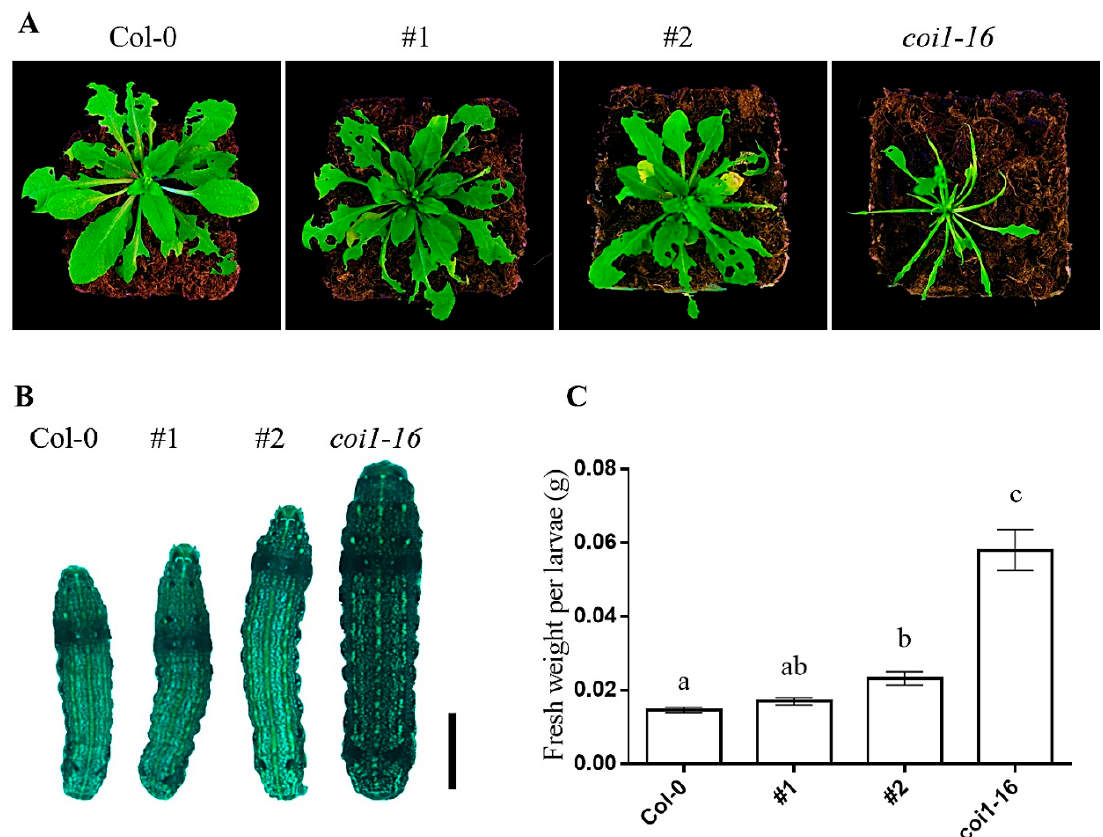
Figure 7. The defense response to herbivory in Col-0, #1, #2, and coi1-16 mutant. The overall appearance of Arabidopsis plants after 10 days of feeding by larvae ( A ); the overall appearance of larvae after feeding on Arabidopsis for 10 days ( B ); the fresh weight per larva after 10 days of feeding on Arabidopsis plants were measured ( C ). The error bar represents the mean ( ± standard error) of at least 20 biological replicates. Columns marked with di ff erent letters ( a – c ) are significantly di ff erent from the others (ANOVA followed by Tukey’s multiple comparison test ( p < 0.05)).